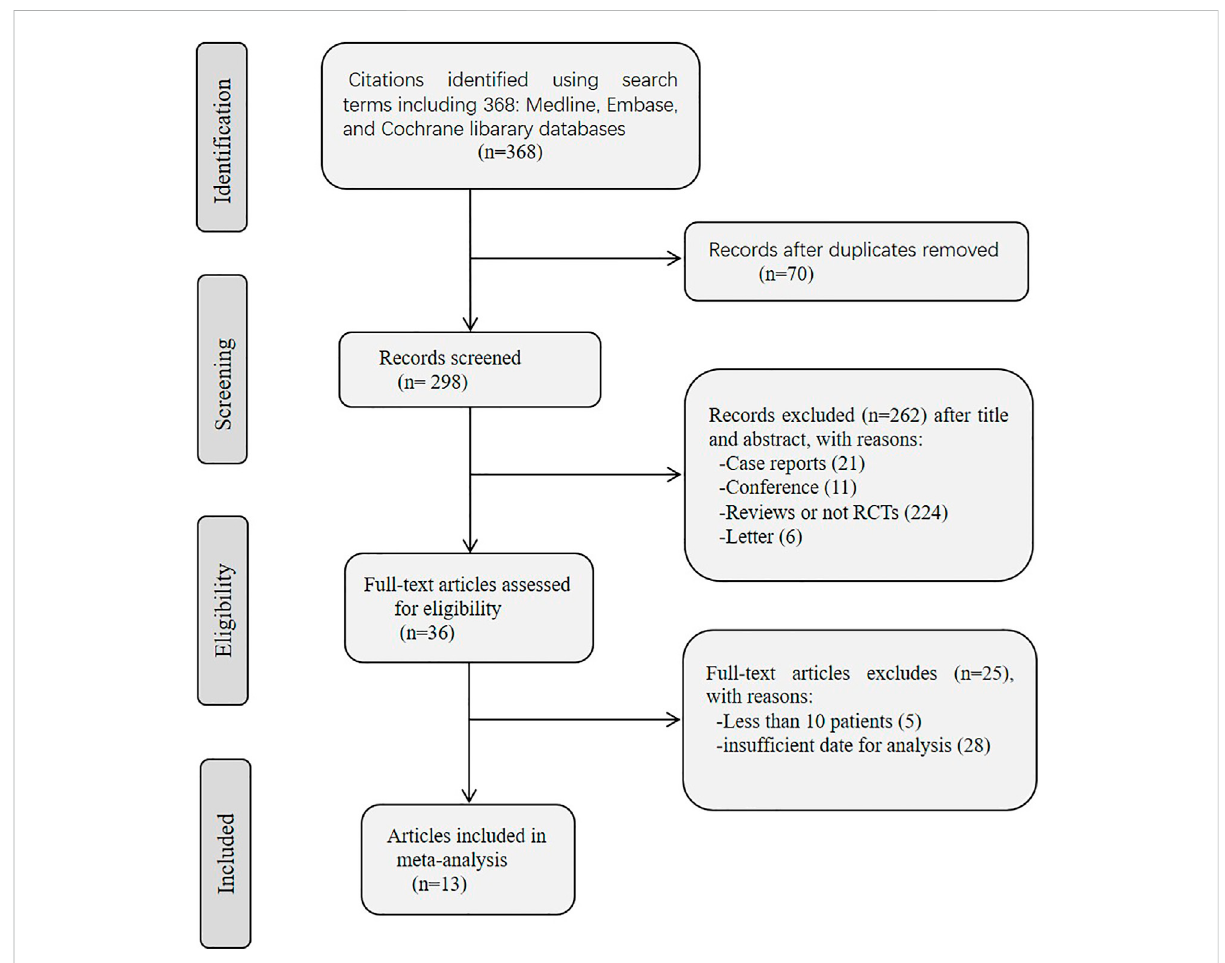
FIGURE 1 Flow diagram of study selection process for this systematic review and